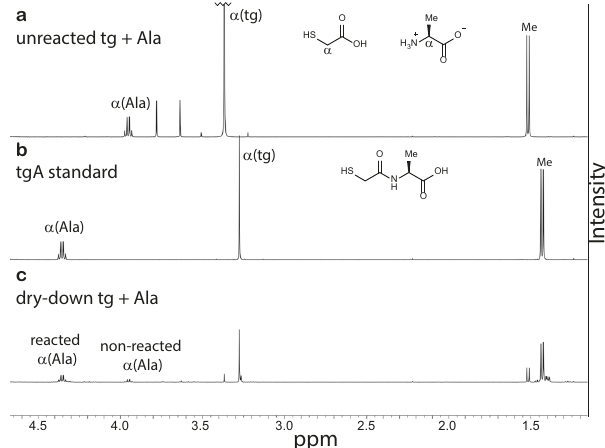
Fig. 3 Amide bonds form upon dry-down of amino acid and a mercaptoacid as indicated by MS/MS Higher-energy C-trap dissociation (HCD) analysis. tg and Ala were dried at 65 °C for 7 days; the resulting products were analyzed by negative-ion mode MS/MS. Tandem MS analysis was conducted using m/z 162.0 as the precursor ion. Negative-ion mode MS/MS analysis of the [tg + Ala-H 2 O] molecule showed a base peak at m/z 88.0385, being the y 1 ion of the sequence tgA. This fragmentation pattern is supportive of the formation of amide bonds in these dry-down reactions.